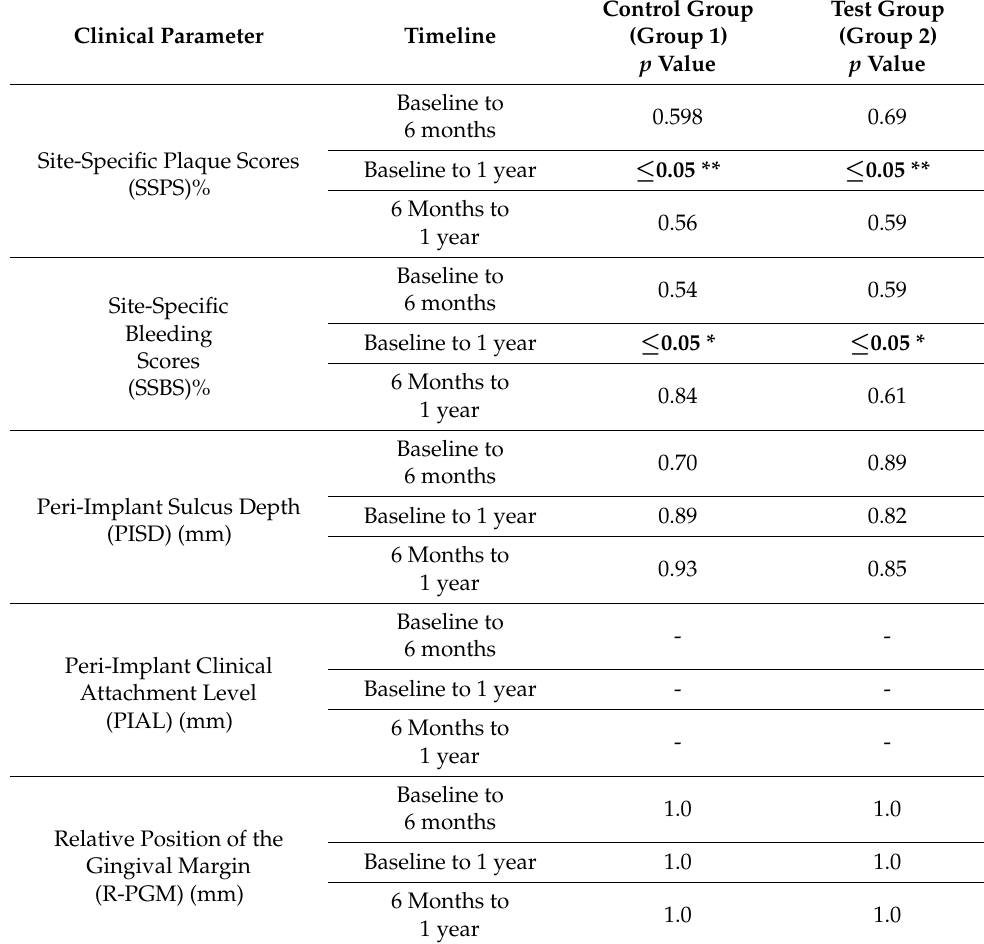
Table 3. Intragroup comparison of clinical parameters between different timelines.